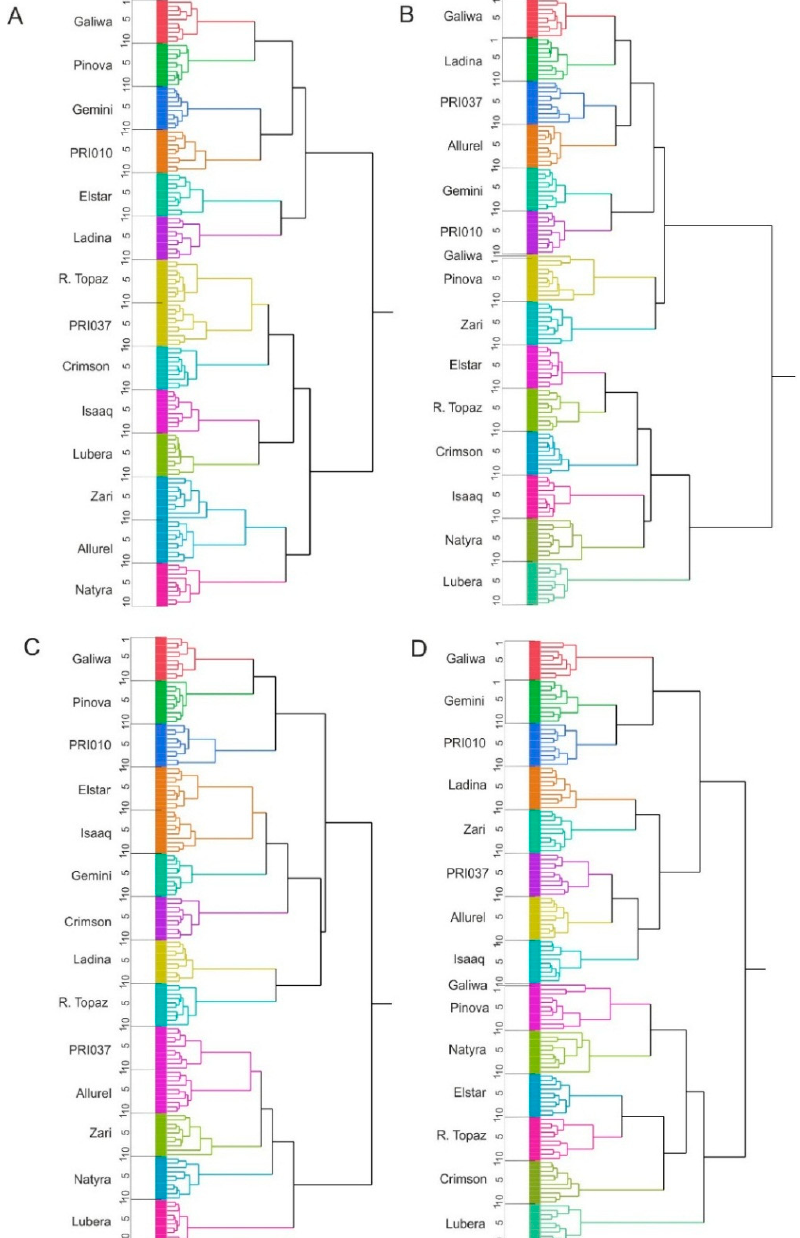
Figure 4. Hierarchical clustering of peel ( A , C ) and pulp ( B , D ) extracts. ( A , B ) All metabolites were used for analysis; ( C , D ) sugars were omitted from the analysis.